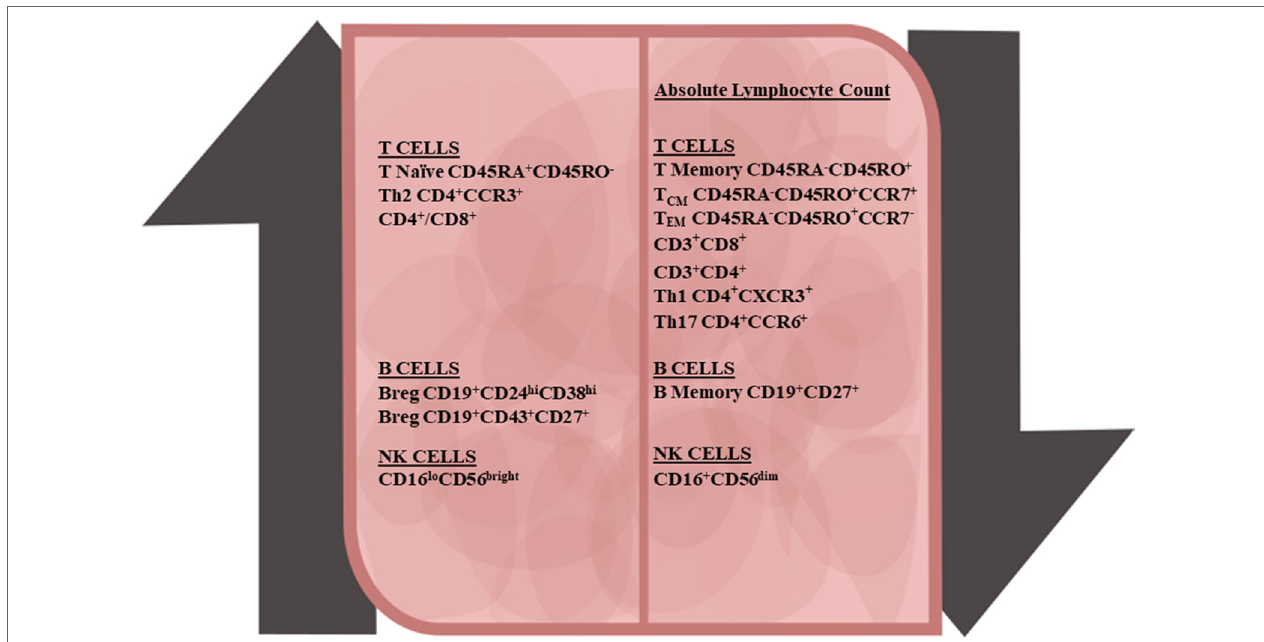
FiGURe 1 | Peripheral immune cell changes due to dimethyl fumarate treatment in multiple sclerosis patients. Along with the decline in the absolute lymphocyte number, all major lymphocyte subsets also declined. T-cells demonstrated the following changes: increases in the naïve CD4 + and CD8 + T-cells and anti- inflammatory T-regulatory and Th2 subsets, and decreases in central memory T-cells, effector memory T-cells, and pro-inflammatory Th1 and Th17 T-cell subsets. In B-cells populations, there was an increase in transitional and B-regulatory subsets and decline in memory B-cells. With natural killer (NK) cells, CD56 bright NK cells were upregulated and CD56 dim NK cells were